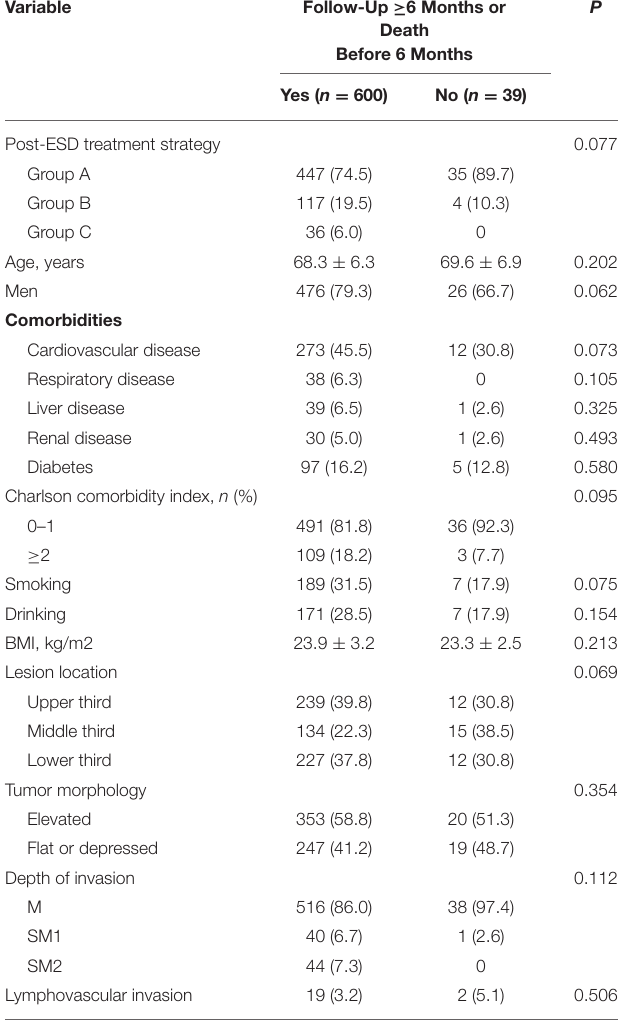
TABLE 4 | Sensitivity